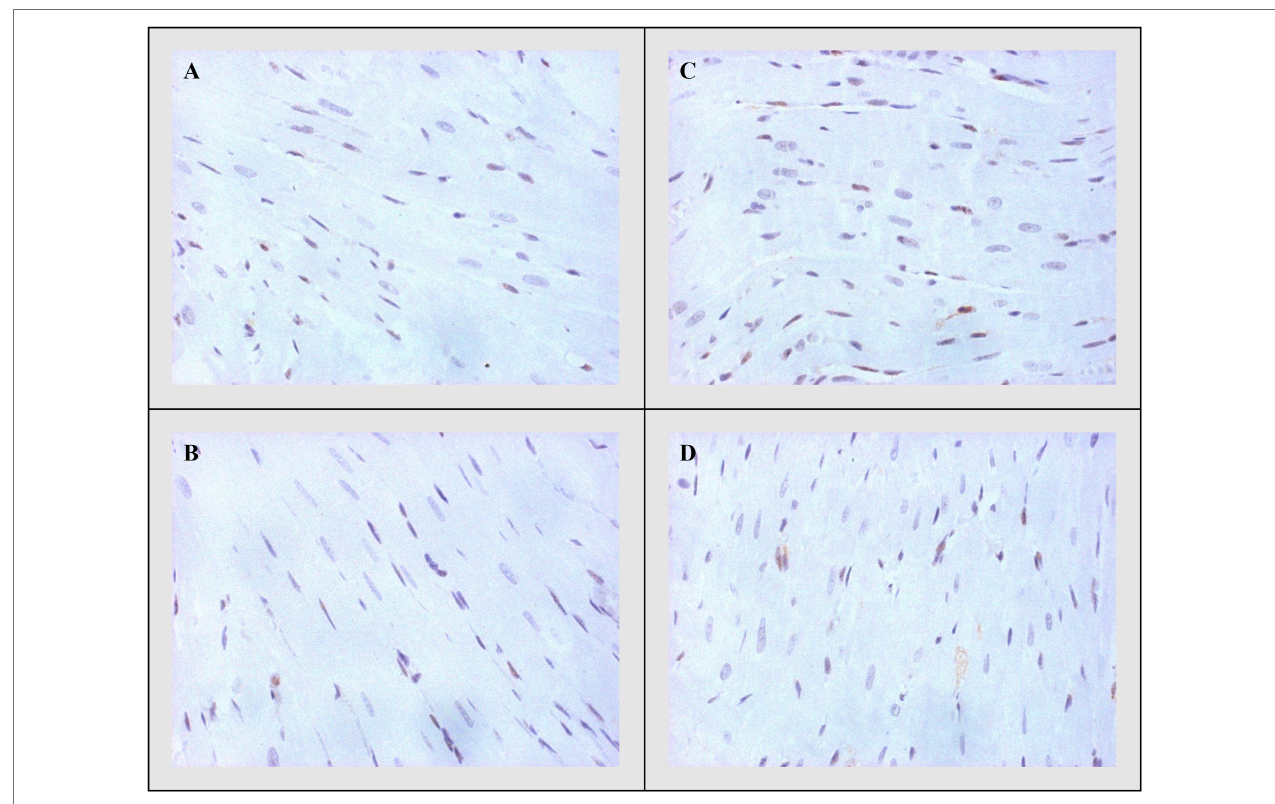
FIGURE 5 | Representative heart tissue sections of immunohistochemical staining of Caspase-3. (A) CTRL, (B) THIA, (C) DOX, and (D) DOX + THIA. Original magnification 20 ×